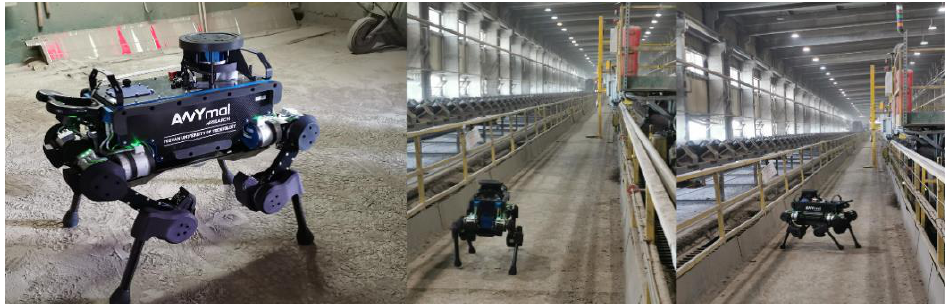
Figure 4. ANYmal robot during inspection task on mining belt conveyor (surface tests in indus- trial conditions).